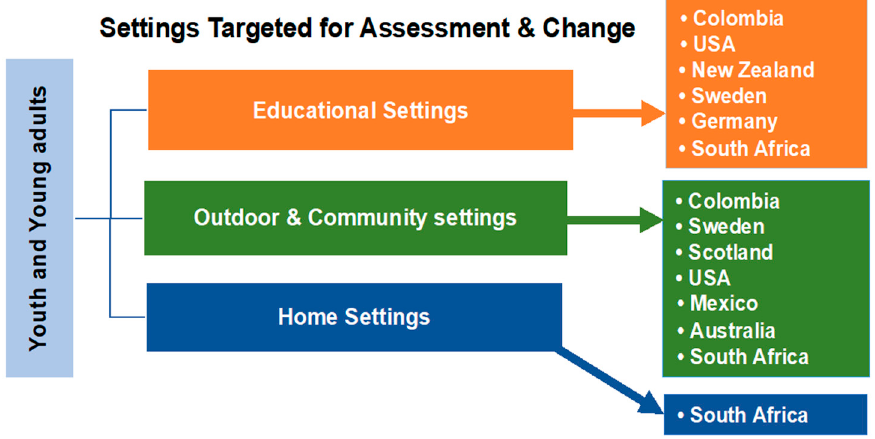
Figure 3. Our Voice youth and young adult projects.